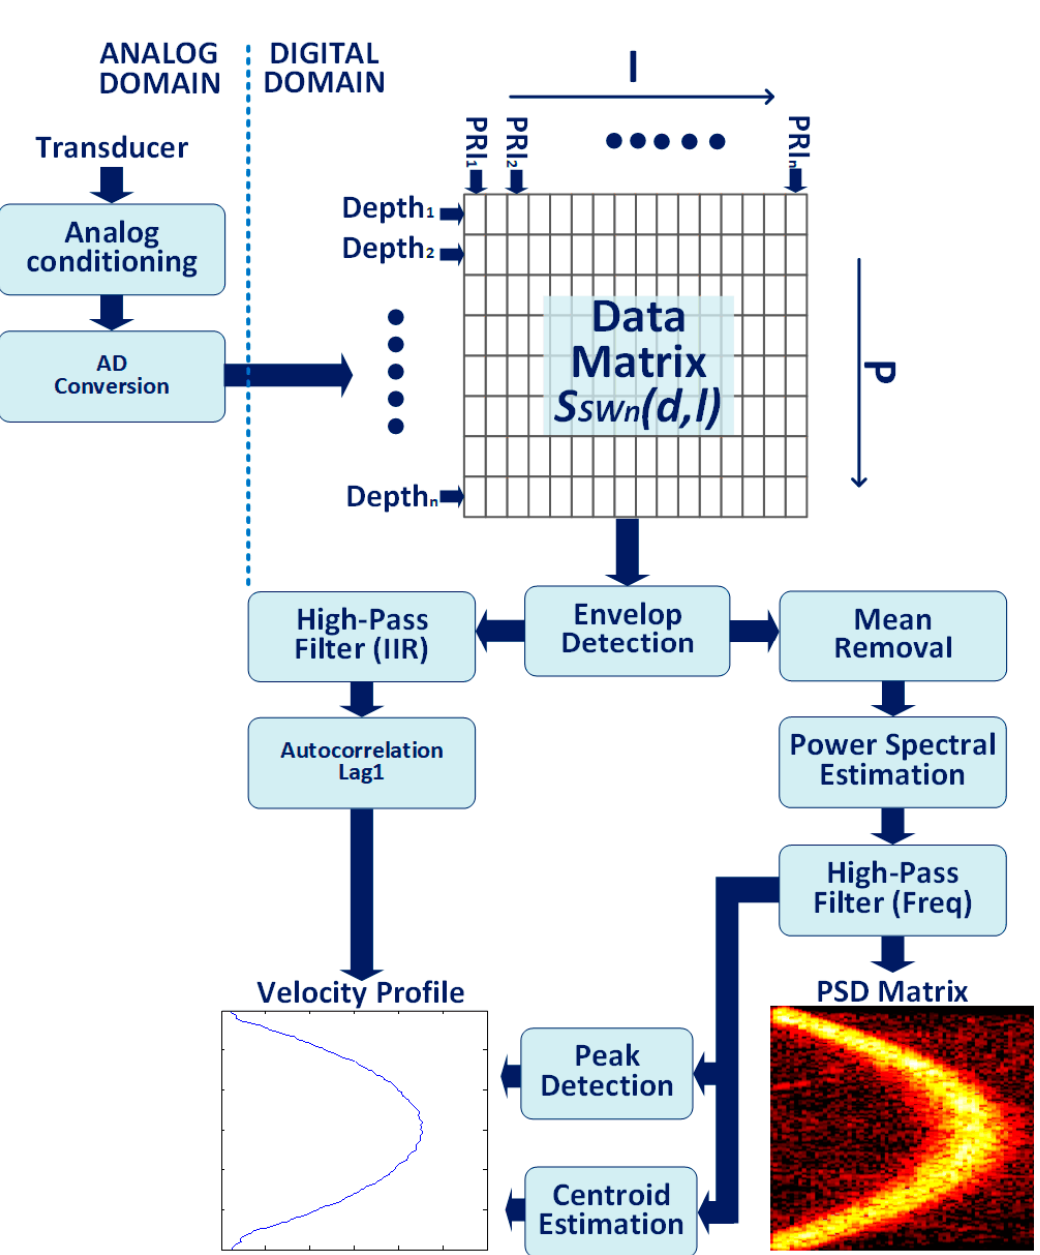
Figure 1. Typical Pulsed Wave Doppler processing. Received echoes are analog-to-digital (AD) converted and organized along the columns of a matrix. The signal is demodulated and processed through high-pass filtering and autocorrelation or, alternatively the power spectral density (PSD) is calculated through spectral estimation. From PSD, the velocity is recovered through peak detection or centroid estimation.